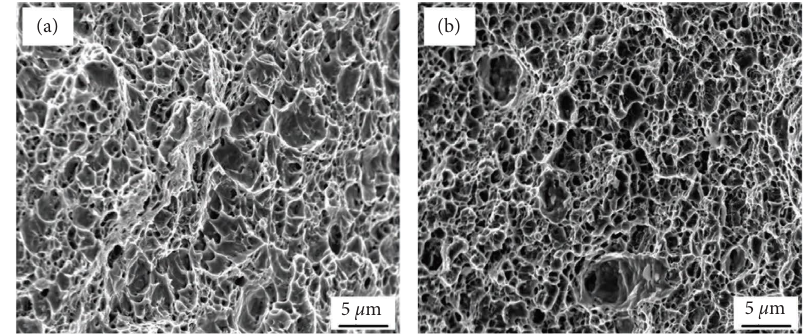
Figure 7: Impact fracture morphologies of experimental steels at − 20 ° C. (a) Steel A. (b) Steel